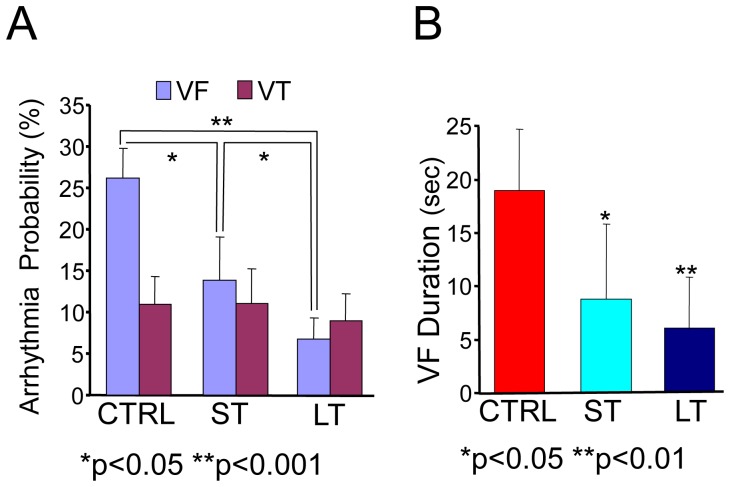
Probability and duration of VT/VF episodes.A. Probability for VT and VF induction as percentage number of events per 1000 stimuli. B. Duration of contiguous episodes of VF in the 3 groups (p<0.05 for ST to CTRL and p<0.01 for LT to CTRL).